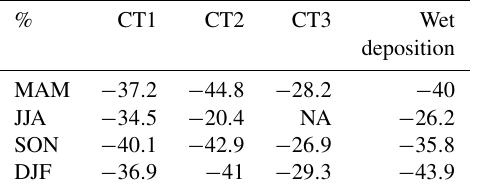
Table 2. The average relative difference of PM 2 . 5 concentrations before and after the occurrence of decay processes (i.e., ( PM t − PM t − 1 )/ PM t − 1 · 100, where PM t is the daily mean PM 2 . 5 concen- tration on the decay phase